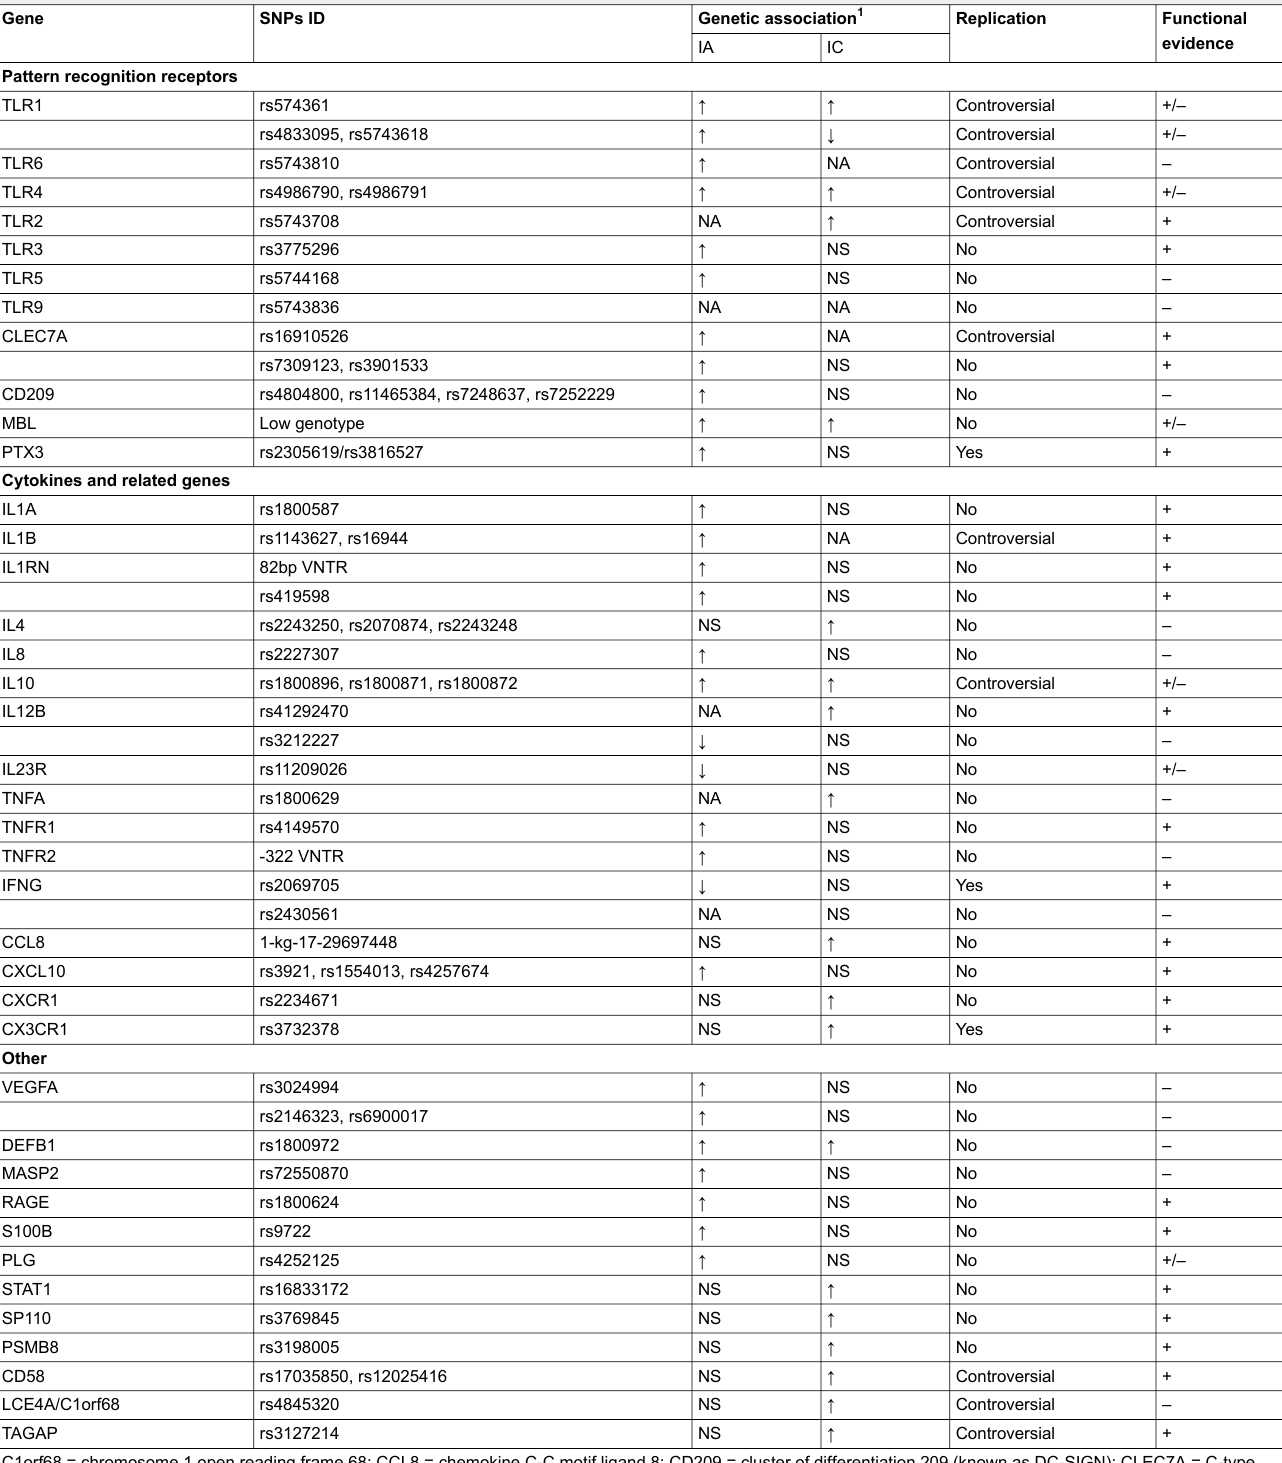
Table 1: Genetic risk factors for invasive fungal